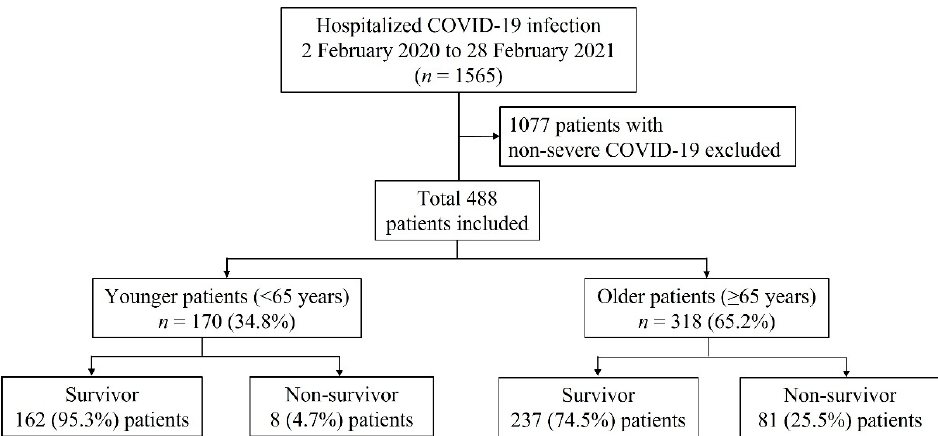
Figure 1. Patient flowchart, COVID-19: coronavirus disease 2019.